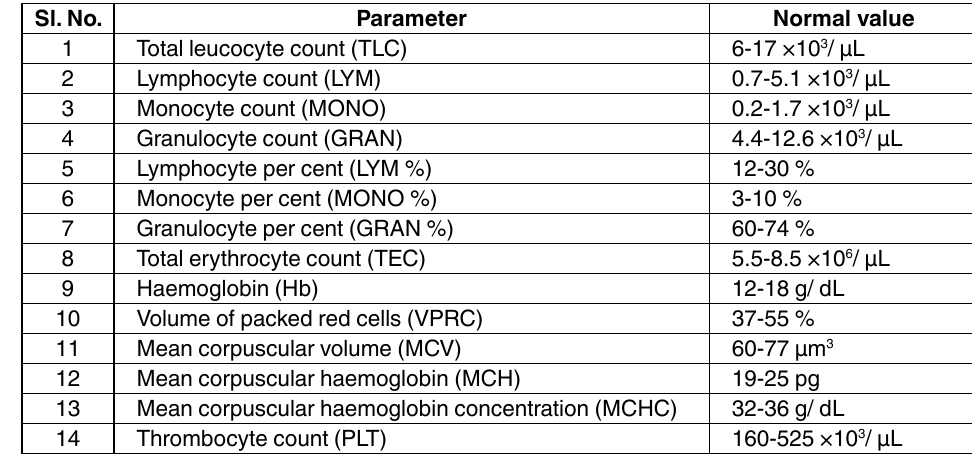
table 2. Reference range for various haematological parameters in dogs sl. No.